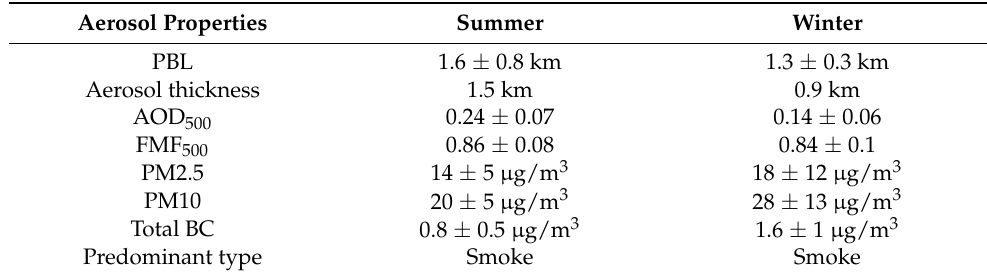
Table 2. Mean insitu, layering and columnar retrievals, along with their standard deviation during the two PANACEA